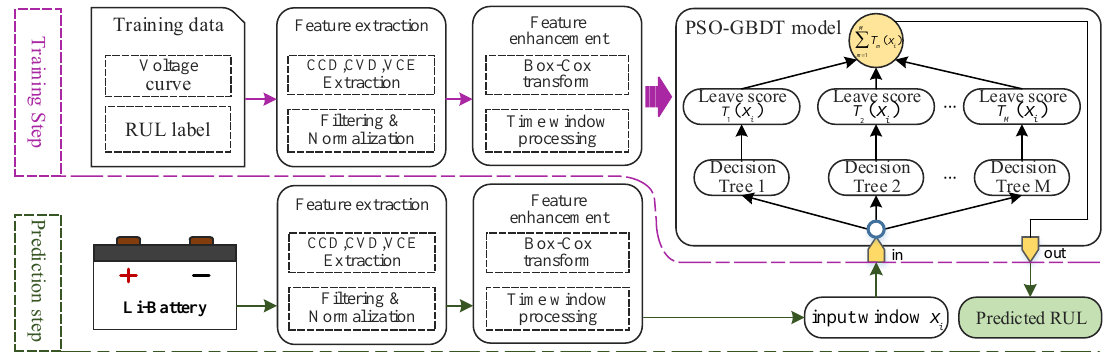
Figure 1. Schematic of the proposed method for lithium-ion battery remaining useful life (RUL)